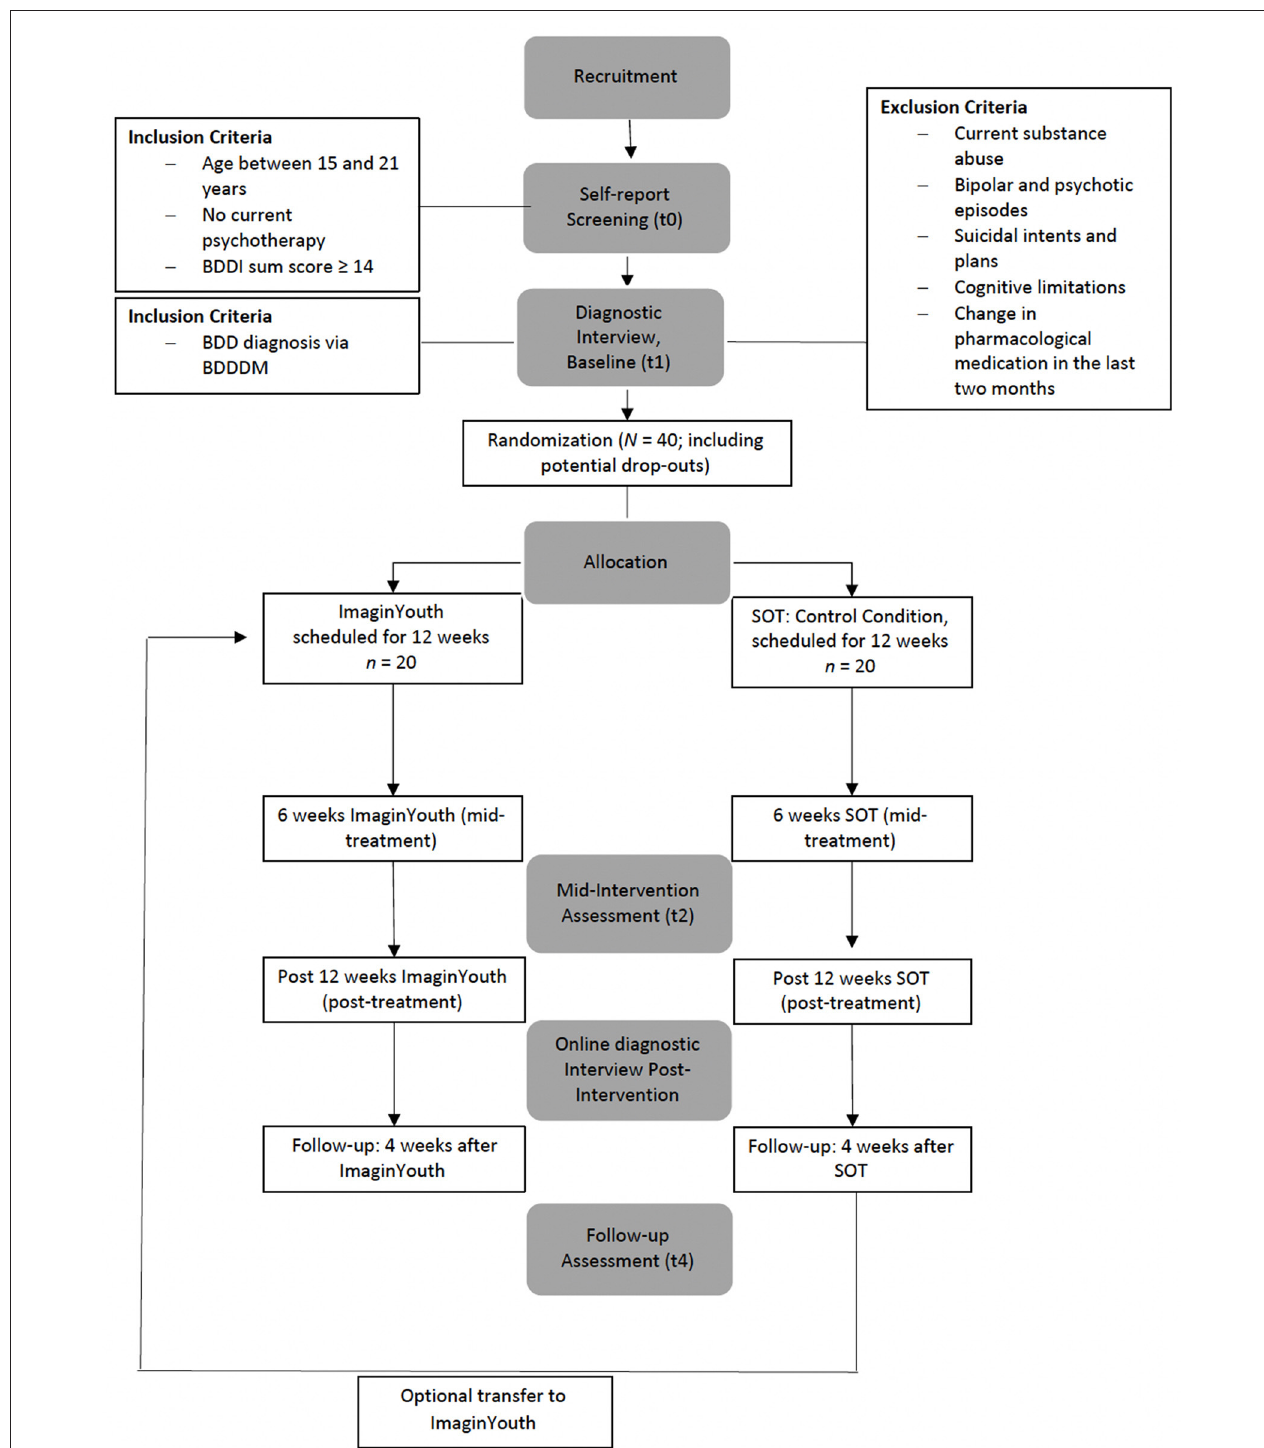
FIGURE 1 | Flow chart illustrating the study